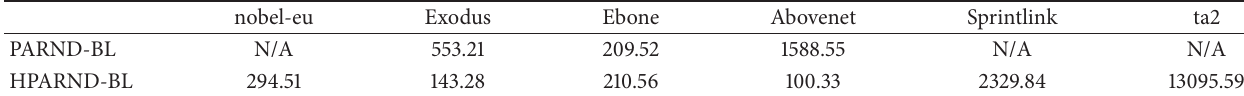
Table 10: CPU times (s)—logarithmic